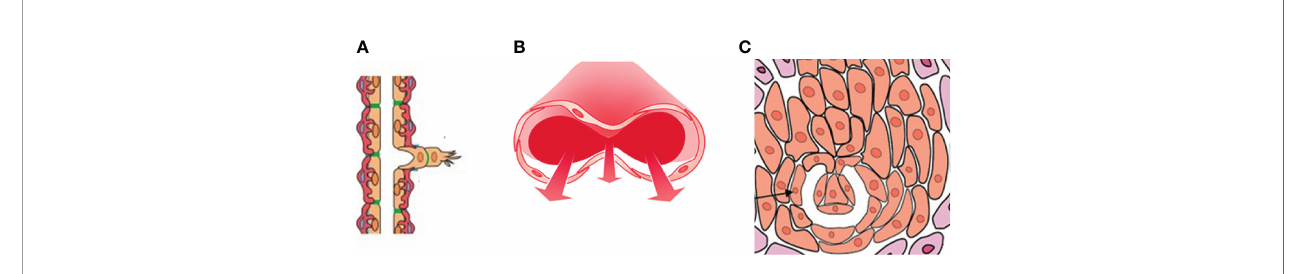
FIGURE 1 | A drawing showing the three types of angiogenesis have been described in tumor growth: (A) sprouting angiogenesis, (B) intussusceptive microvascular growth (IMG), and (C) glomeruloid vascular proliferation. Sprouting angiogenesis involves formation and outgrowth of sprouts; IMG involves the formation of new vasculature where a pre-existing vessel splits in two; in glomeruloid vascular proliferation small glomeruloid bodies, so-called for their morphological resemblance with the renal glomeruli, are recognizable.